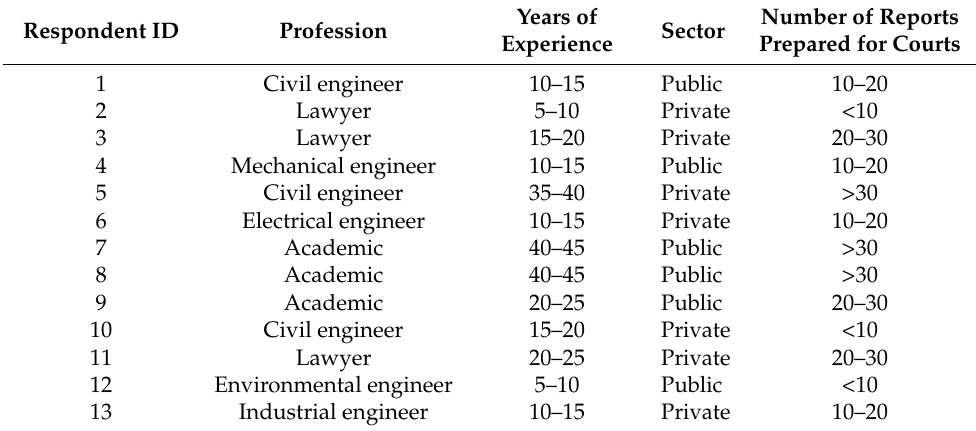
Table 4. Profile of the thirteen Participants in the Brainstorming